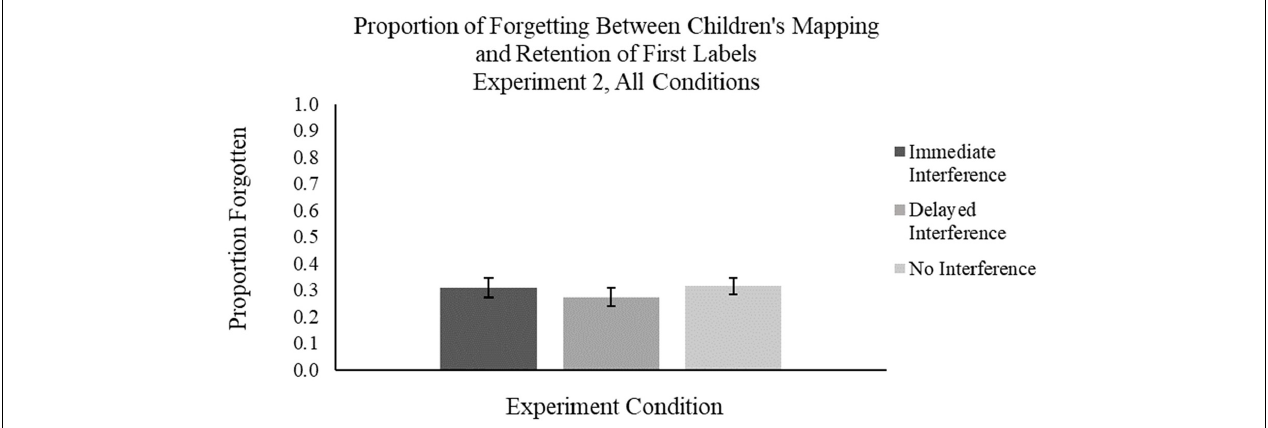
FIGURE 9 | Mean proportion of children’s forgetting of novel labels from learning phase to testing phase, by condition. Error bars represent one standard error.